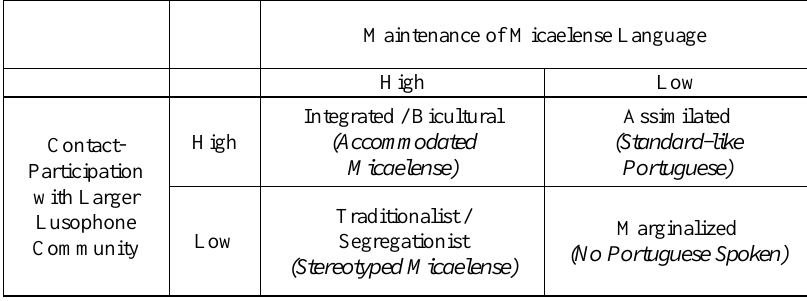
Figure 11: Matrix of Micaelense Language Maintenance vs. Contact-Participation with the Larger Lusophone